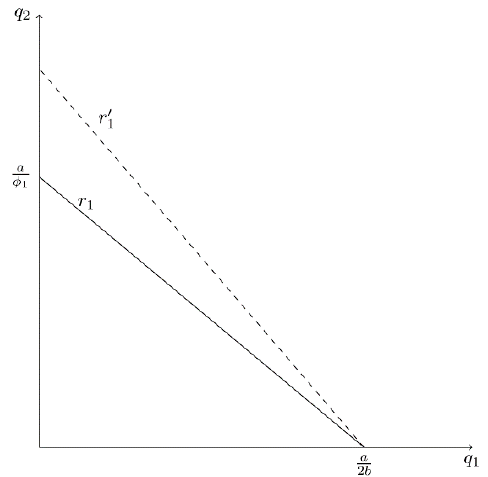
Figure 1. Firm 1’s Best-Reply Curve ( r 1 ) in the Cournot Model when CEO 1 Underestimates Product Substitutability.